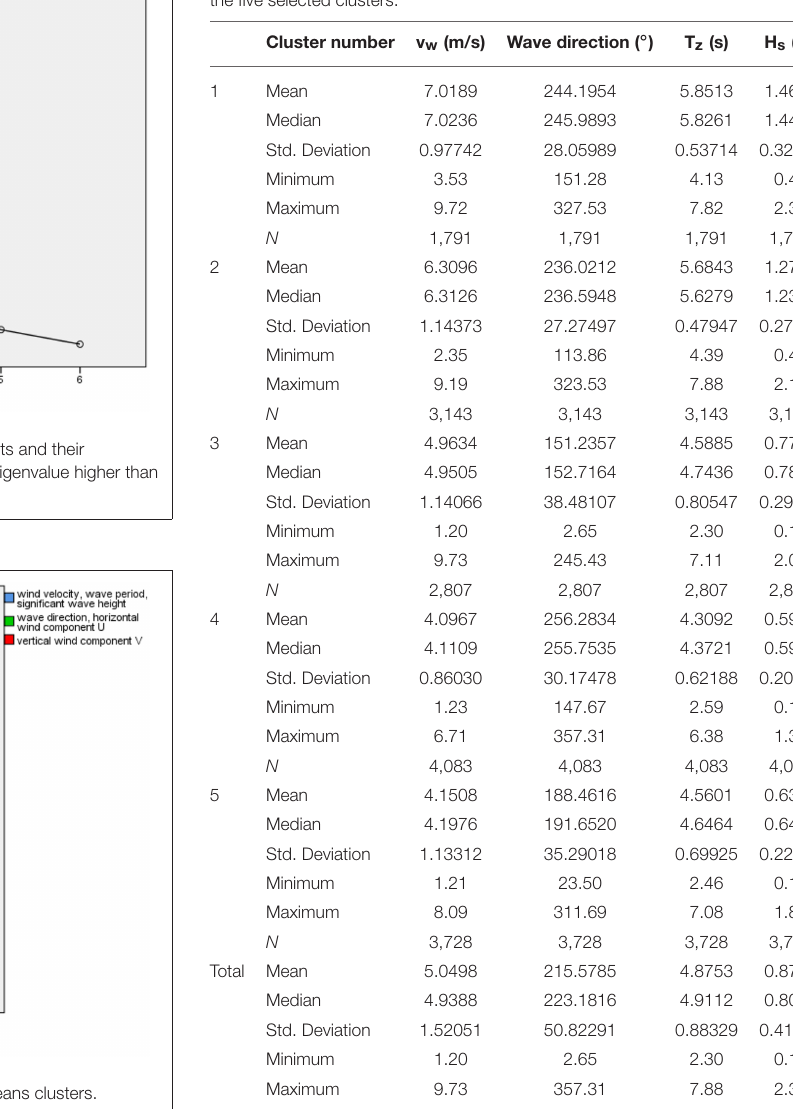
FIGURE 7 | Standardized characteristics of the five K-means clusters. K-means cluster 1 and 2 shows the most favorable meteo-climatic conditions for combined offshore wind and wave energy technologies.